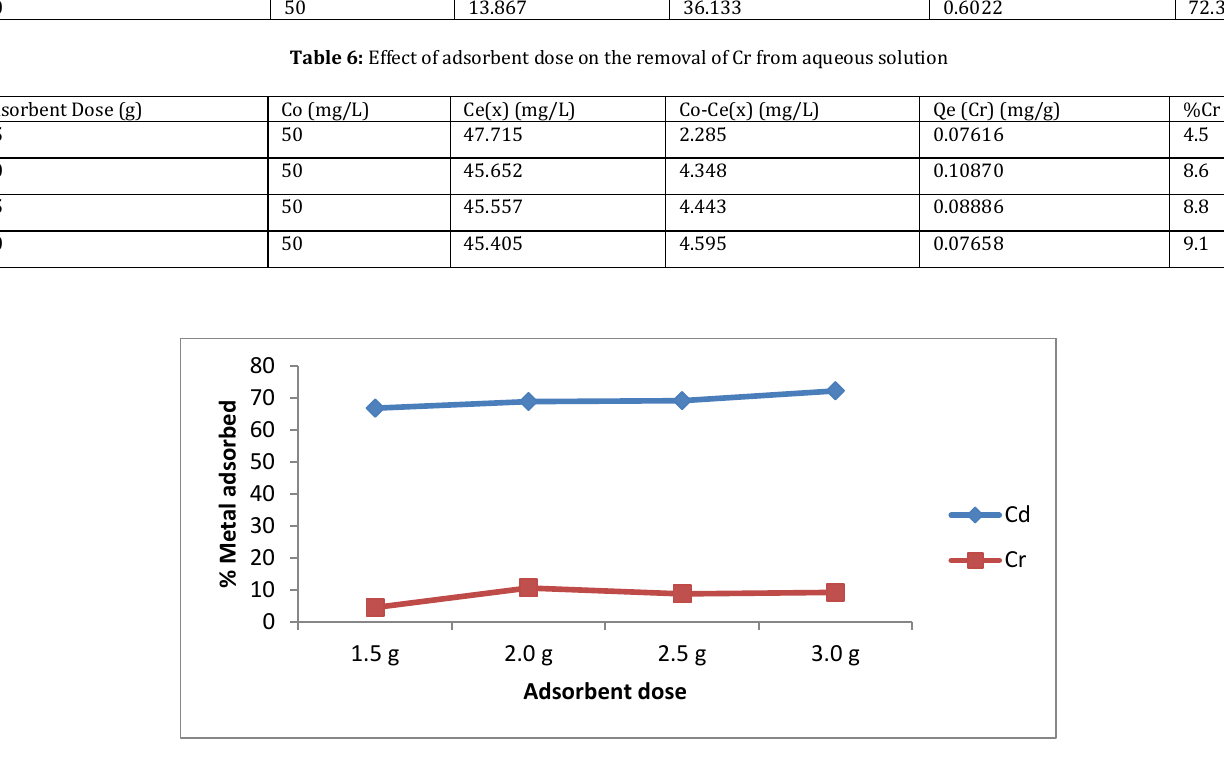
Figure 4: Effect of Adsorbent dose on the removal of Cd and Cr from aqueous solution